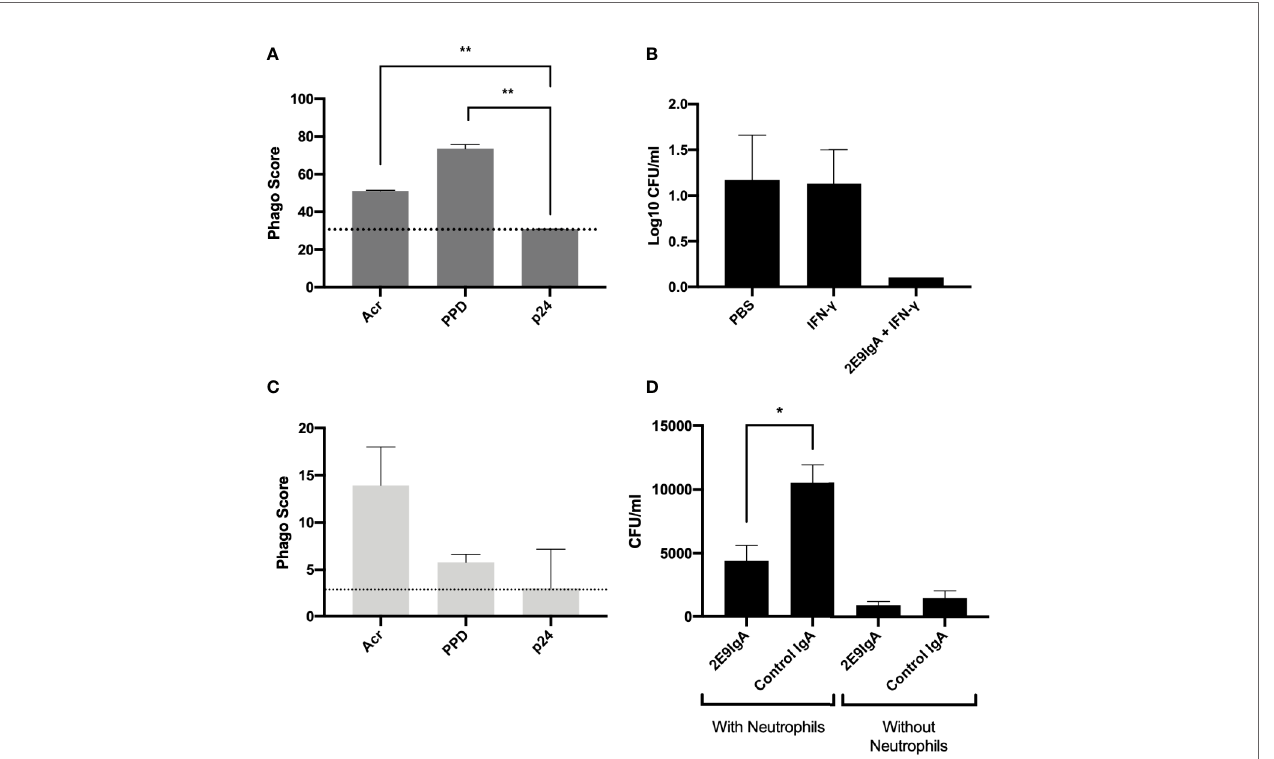
FIGURE 4 | In vitro 2E9IgA1 modulation of phagocytic uptake and mycobacterial infection. Macrophage THP-1 cell phagocytic uptake of beads opsonised with Acr or PPD mediated by 2E9IgA1 at 0.5 µg/ml (A) . Macrophage U937 monocyte infection with M. tuberculosis in the presence or absence of CIT (B) ; cells were infected for fi ve days and shown are the means + SEM of triplicate cultures. Human neutrophil uptake of beads opsonized with Acr (C) . Infection of mouse J774 cells in the presence of 0.1 µg/ml of 2E9IgA1 and human neutrophils (D) ; cells were infected with M. tuberculosis for 24 h and supplemented with neutrophils at a MOI of 5:1 for another 24 h; shown are the means of triplicate cultures + SEM. Neutrophil experiment performed once and macrophage/monocyte twice, with similar outcomes. *p ≤ 0.05, **p ≤ 0.01 as determined by one-way ANOVA with Tukey ’ s